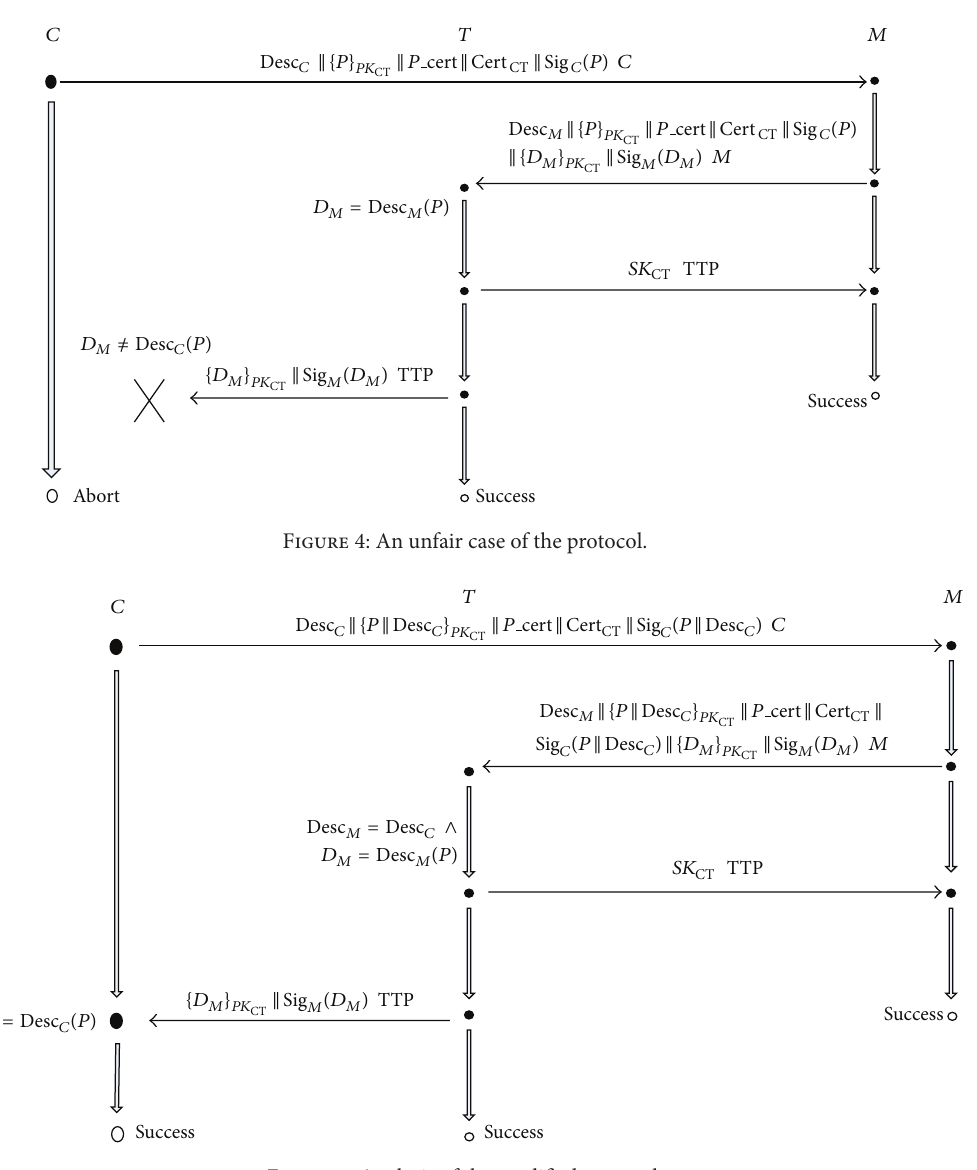
Figure 5: Analysis of the modified